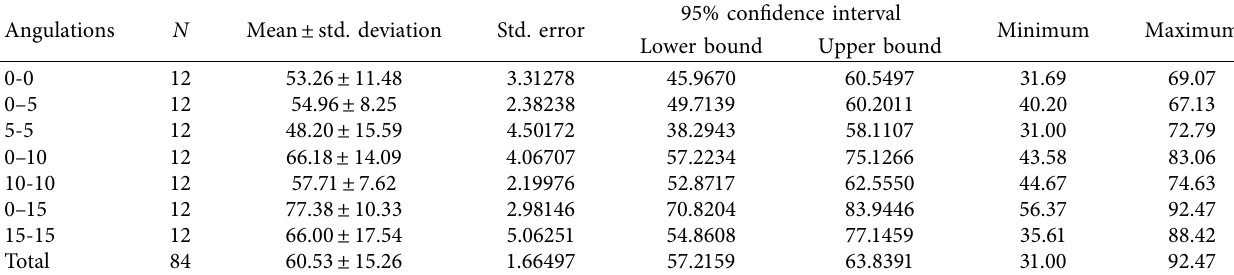
Table 4: Descriptive statistics of different angulations.